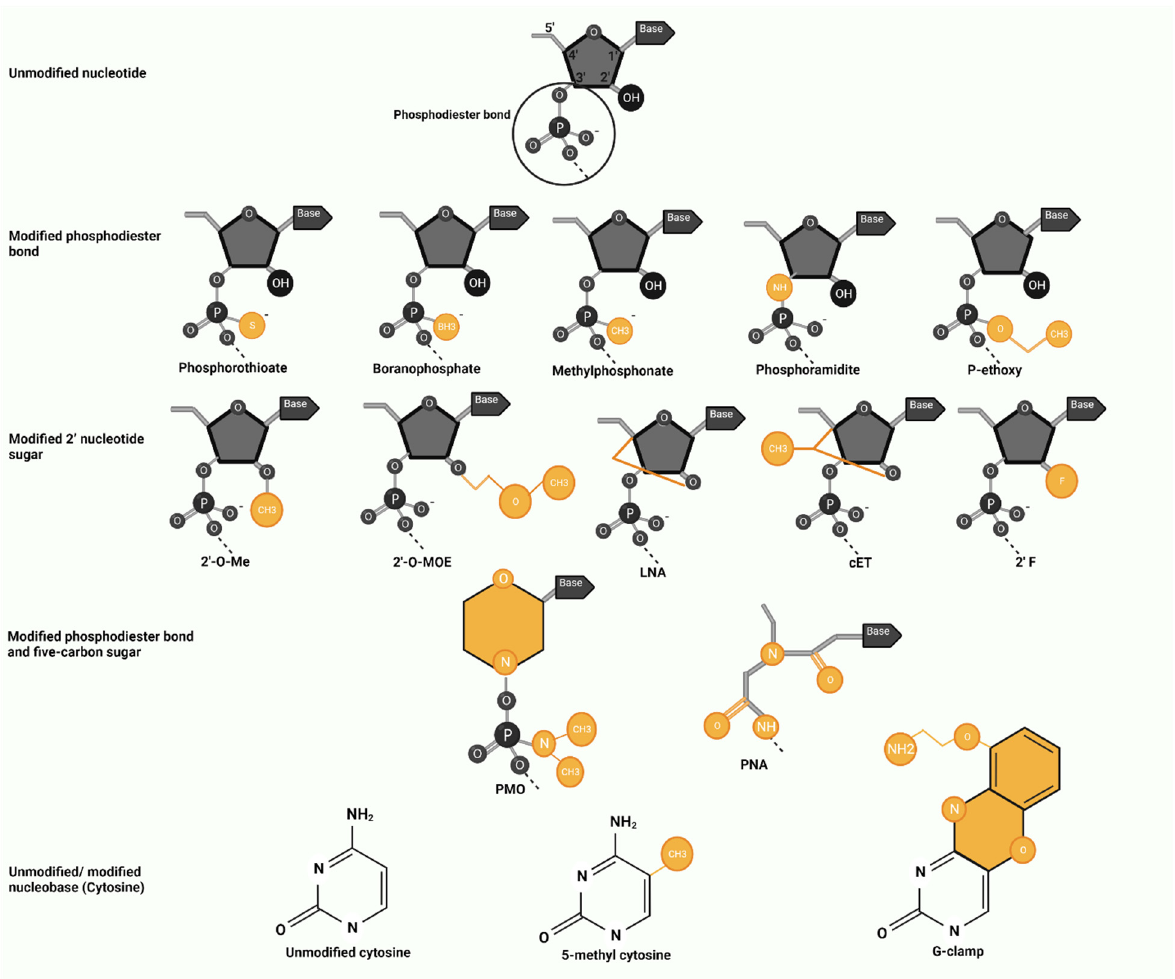
Figure 3. Antisense oligonucleotide modifications include modified phosphodiester bond (e.g., phosphorothioate, boranophosphate, methylphosphonate, phosphoramidite, and p-ethoxy), modified 2 ′ nucleotide sugar (e.g., 2 ′ -O-methyl (2 ′ -O-Me), 2 ′ -O-methoxyethyl (2 ′ -O-MOE), locked nucleic acid (LNA), constrained ethyl (cEt), and 2 ′ -fluoro (2 ′ F)), modified phosphodiester bond and five-carbon sugar (e.g., phosphorodiamidate morpholino oligomer (PMO) and peptide nucleic acid (PNA)) and modified nucleobase (e.g., 5-methyl cytosine and G-clamp). “Schematic diagram created with premade icons and templates from biorender.com (accessed on 20 August, 2022)”.